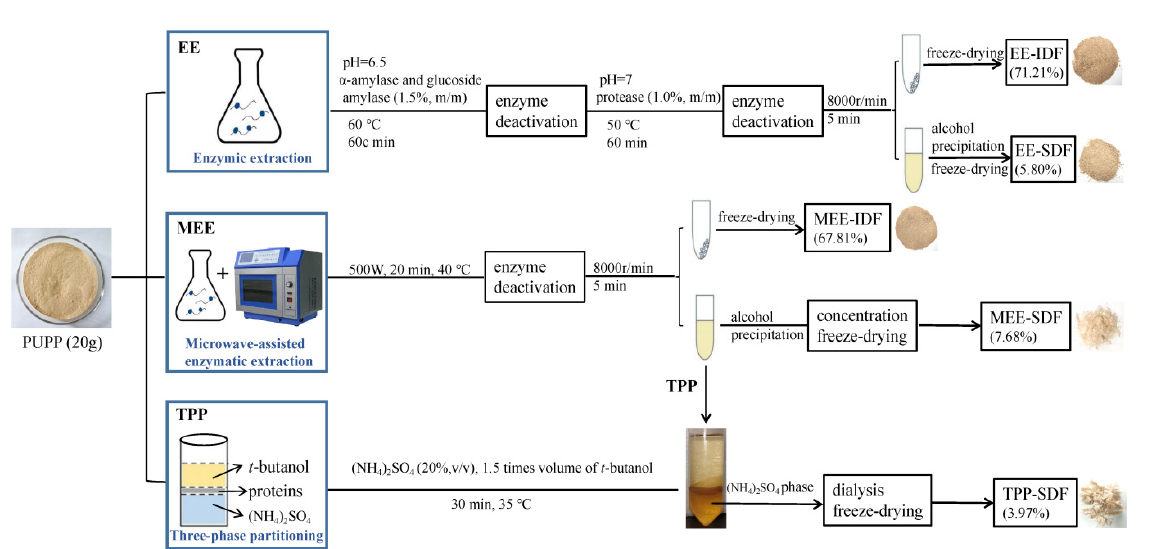
Figure 1. Schematic procedures for the extraction of dietary fiber from